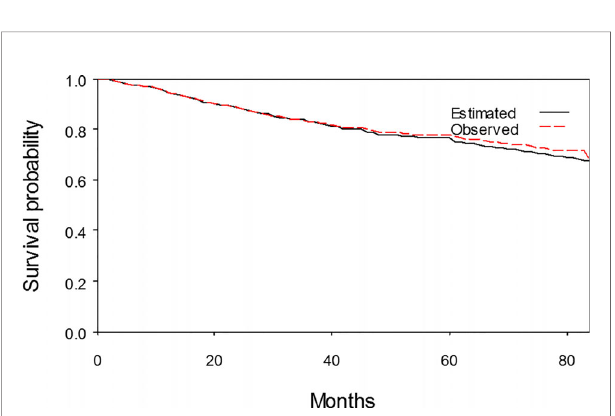
FIGURE 3 | Dynamic change in different functional impairments or problems for nasopharyngeal cancer patients. The estimated lifelong duration of any functional impairments or problems were the areas under the quality-adjusted survival curves. The estimated lifelong duration of any impairment of swallowing, speech, smell, and taste were 14.0, 9.8, 8.7, and 7.5 years, respectively. The estimated lifelong duration of problems with dry mouth, teeth, emotion, fatigue, sleep and social contact were 13.4, 10.1, 9.1, 12.3, 6.7, and 4.5 years, respectively.